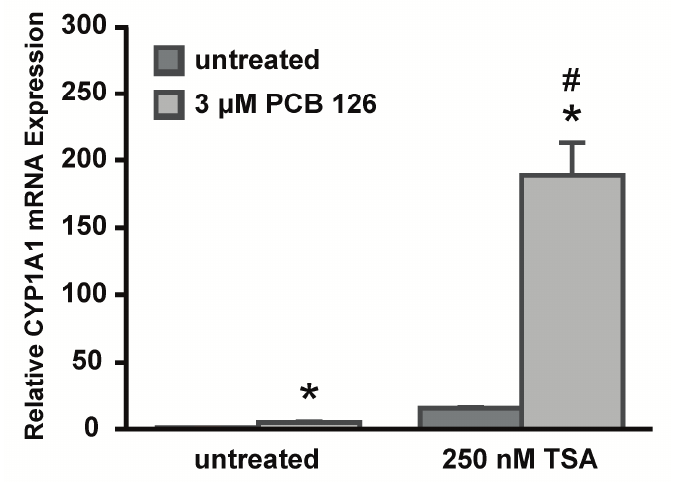
cells. HeLa cells were either left untreated or treated with 250 nM TSA for 16 h prior to treatment with 3 µM PCB 126 for 6 h. CYP1A1 mRNA expression was determined by qRT-PCR with normalization to RPLP0 mRNA. * p < 0.05 vs. control; # no drug treatment vs. TSA treatment; Error bars = SEM; n = 3.